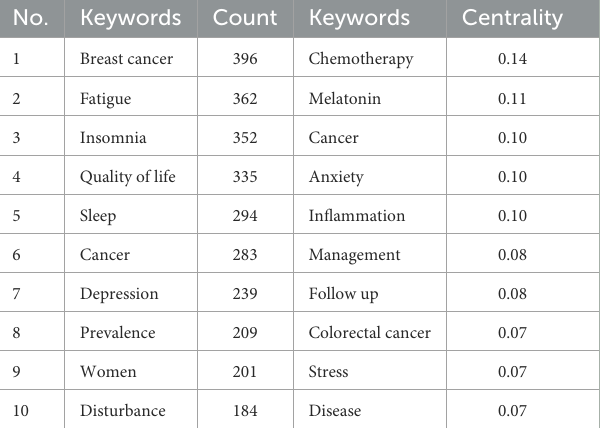
TABLE 3 Top 10 keywords in terms of count and